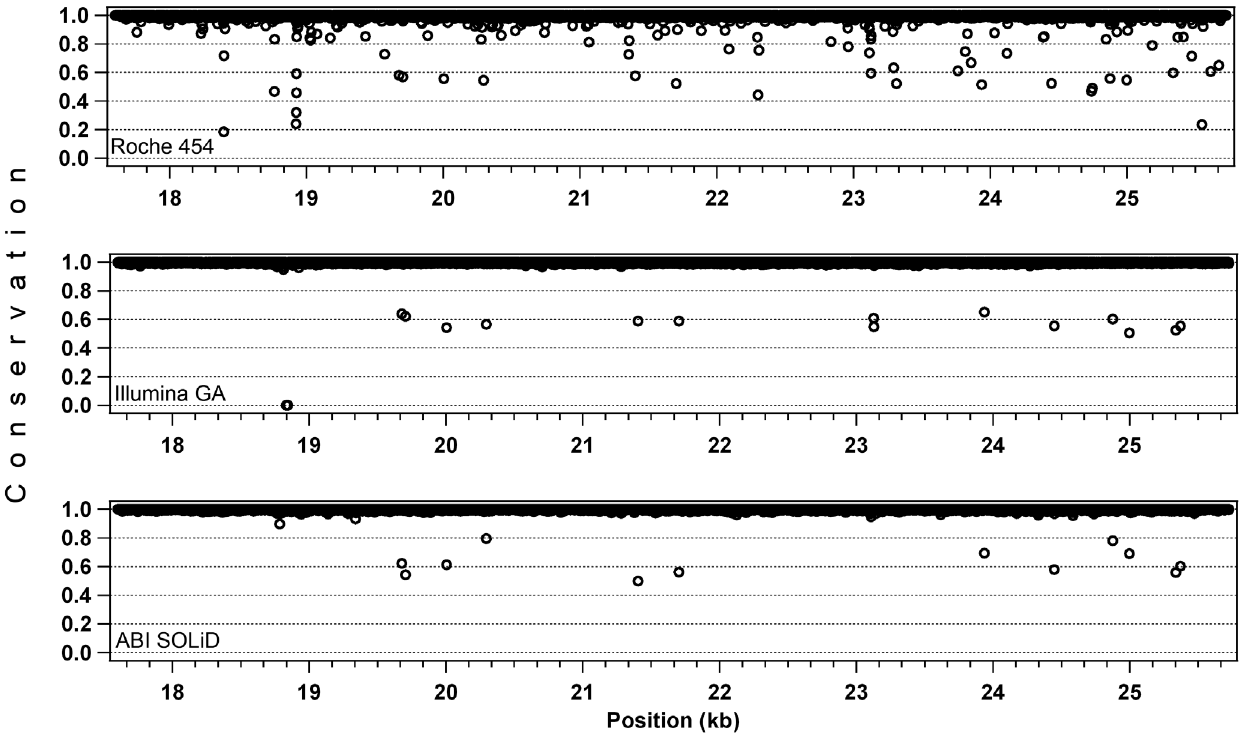
Figure 3. Read accuracy evaluation, on the 3rd long-range PCR fragment ( , 8 kb). Values on the Y axis (conservation) indicate the fraction of the most prevalent base at a given position, as detected from the reads covering that position. Conservation scores below 0.5 represent gaps of the assembly with respect to the reference sequence. In the Roche 454 assembly this occurs when the majority of the reads have an indel with respect to the ref_seq, while in the Illumina GA alignment the point at 0% conservation corresponds to a region with no coverage (position: 18,837- 44).